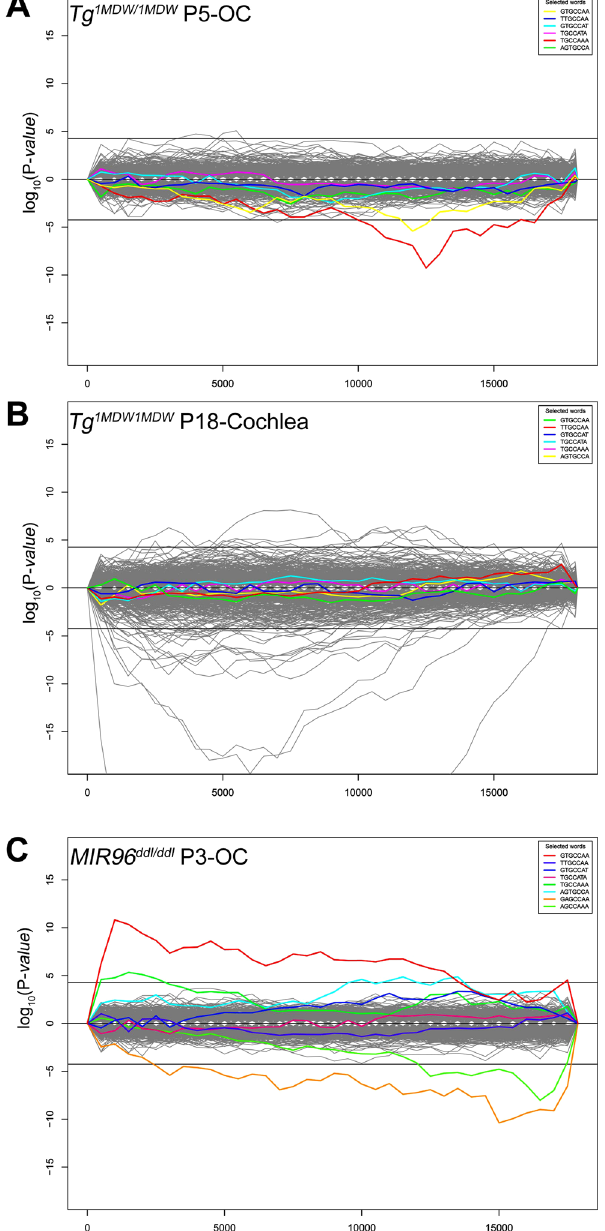
Figure 6. Sylamer analysis of microarray data showing enrichment and depletion for 911 miRNA heptamer seed sequences in 3 ′ UTRs. ( A ) Tg 1MDW/1MDW P5-OC demonstrates significant depletion of 2 miR-183 cluster heptamers (GTGCCAA, TGCCAAA), validating this miRNA misexpression model. The x axis is the number of all microarray genes sorted from most upregulated (left) to most downregulated (right). The y axis shows the hypergeometric significance for enrichment or depletion of heptamers in 3 ′ UTRs at leading parts of the gene list. Positive values indicate enrichment [-log 10 (P)] and negative values depletion [log 10 (P)]. Horizontal lines represent 0.05 Bonferroni P-value threshold. ( B ) Tg 1MDW/1MDW P18-cochlea microarray fails to demonstrate miR-183 cluster effects, but does show significant imbalances in 3 ′ UTR heptamer representation for dozens of miRNA complementary sequences. ( C ) Analysis of available primary Mir96 ddl/ddl P3-OC microarray data (n = 3) confirms enrichment of miR-96 wt (GTGCCAA, TGCCAAA) and depletion of miR-96 ddl heptamers 2 . All highlighted plots are miR-183 cluster heptamers and include two (2) predicted to complement Mir96 ddl mutant miR-96. Sylamer program reference 34